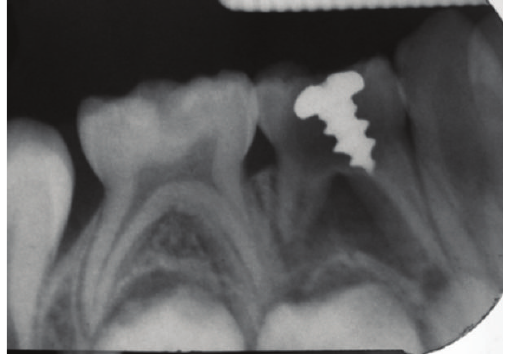
Figure 2: IOPA showing intact furcal area with no evidence of interradicular bone loss.